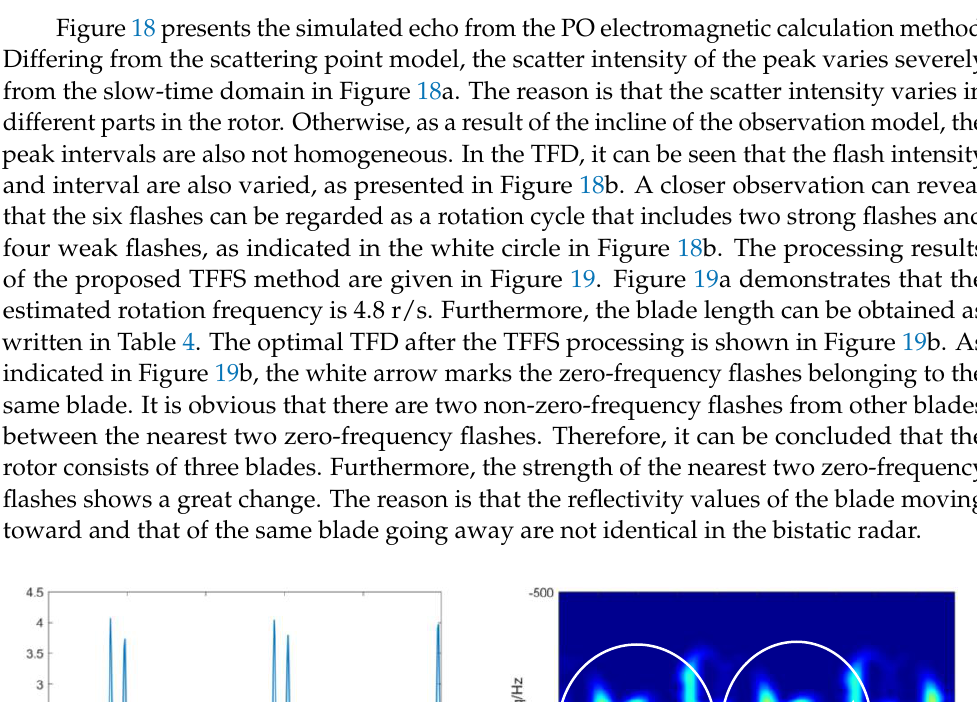
( b ) Figure 19. The processing result of the TFFS: ( a ) parameter estimation results of the TFFS; ( b ) the optimal shifted TFD. Table 4. The estimation results for the methods in the PO facet simulation model. Method